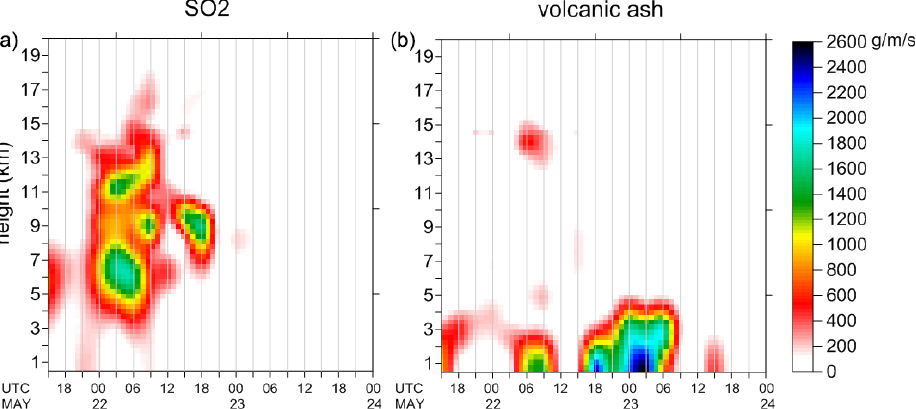
Figure 4. Temporal evolution of hourly-resolved vertical (height a.s.l.) SO 2 (a) and ash (b) emissions from FLEXPART inverse modelling based on IASI data. Data obtained from Moxnes et al. (2014).